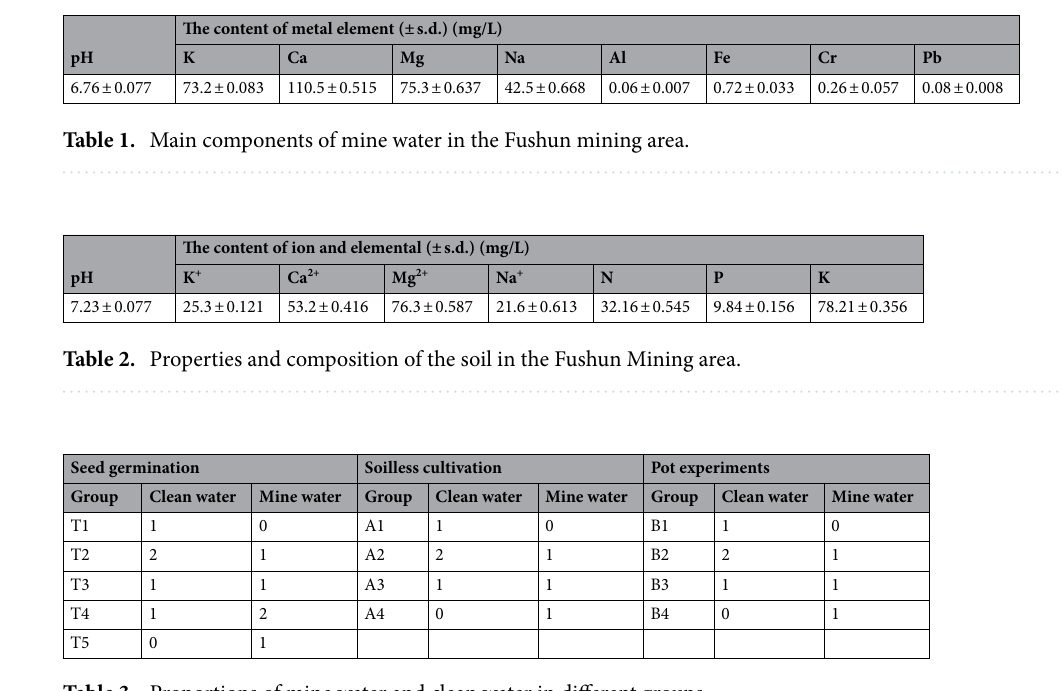
Table 3. Proportions of mine water and clean water in different groups.